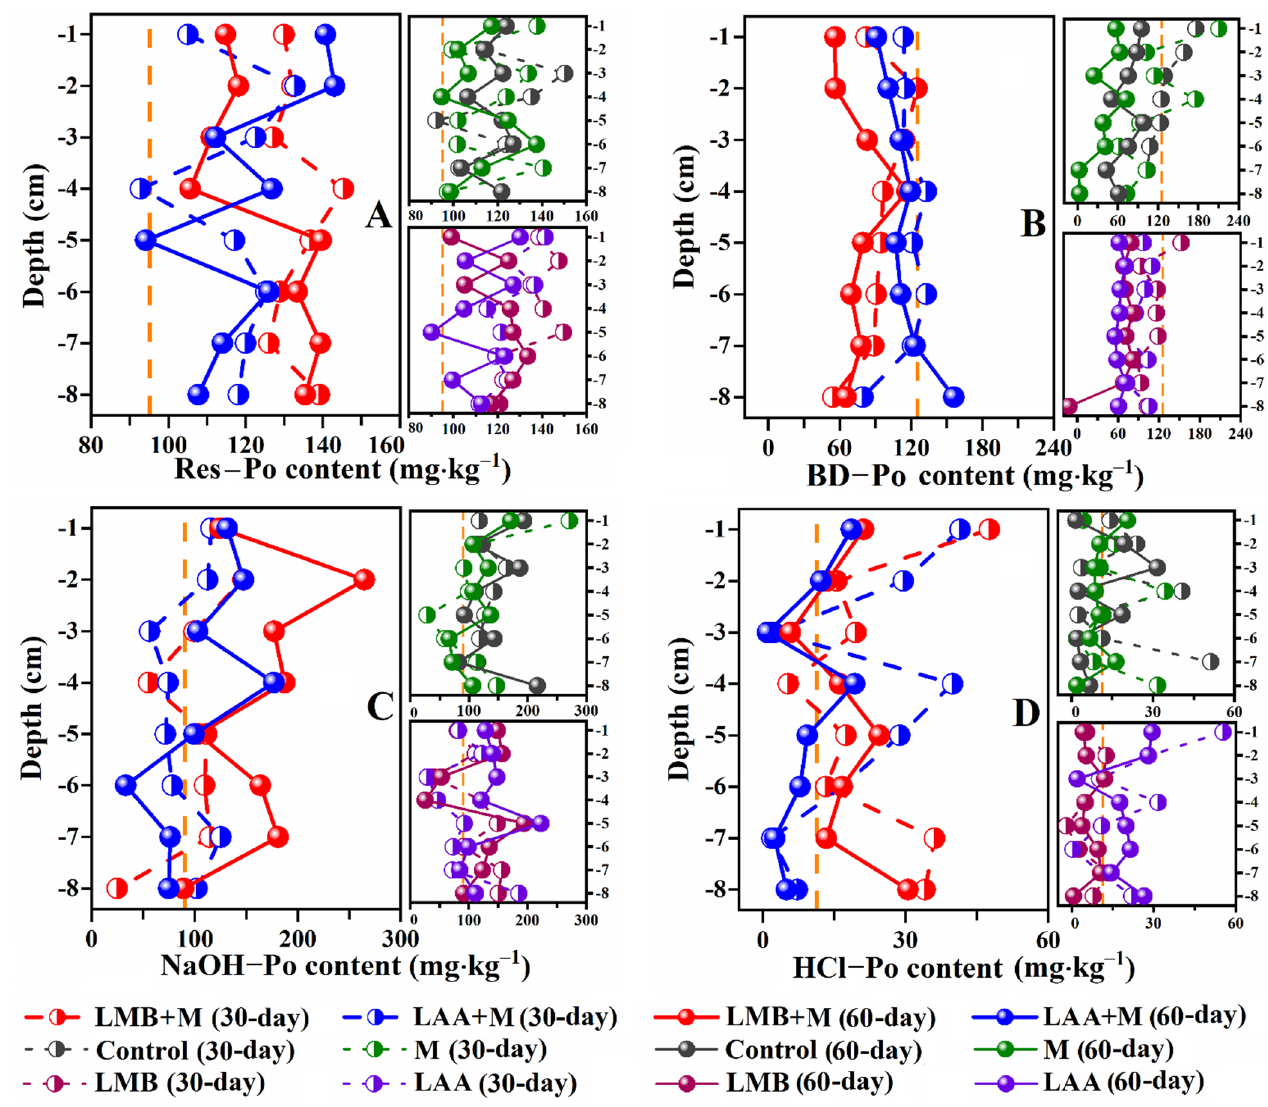
Figure 5. Vertical distribution of different P forms in sediments of the six treatment groups during the experiment. ( A – D ) represent the changes of Res − Po, BD − Po, NaOH − Po and HCl − Po contents in the sediment, respectively. Each graph consists of three distinct subgraphs. The left subgraphs represent LAA+M and LMB+M groups, respectively. The upper right subgraphs represent control and M groups, respectively. The lower right subgraphs represent LAA and LMB groups, respectively. All data are triplicates. The vertical dashed line is the start P contents of the sediments.